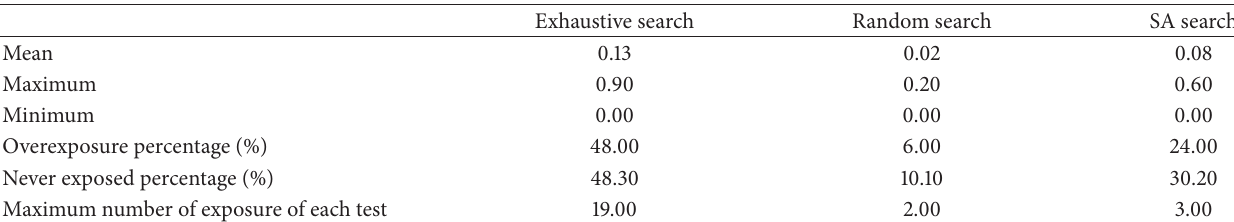
Table 3: Comparison of